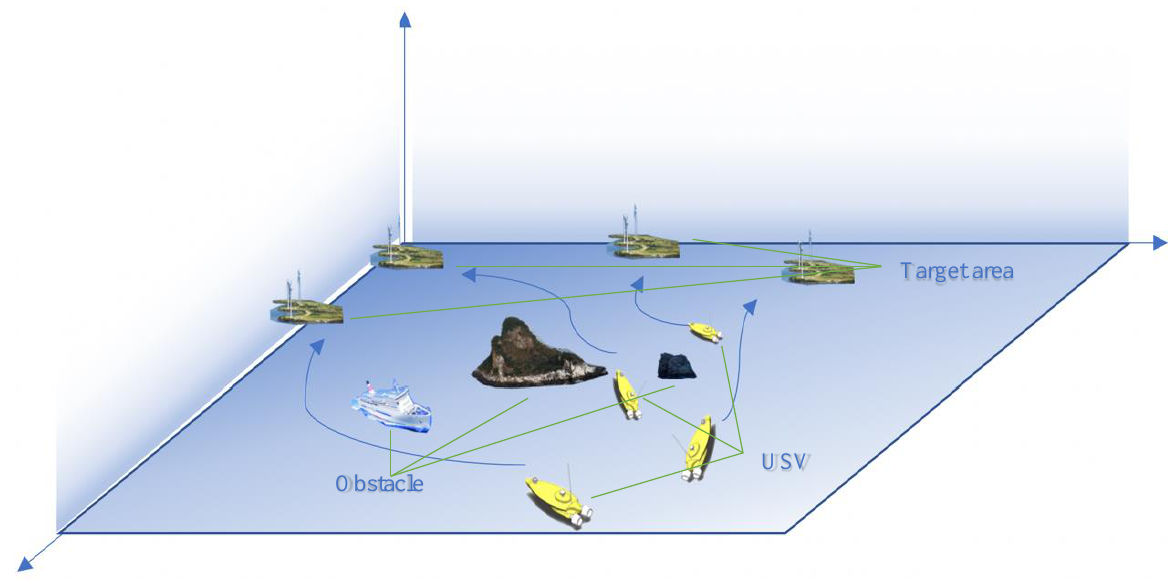
Figure 1. Multi-USV communication system.